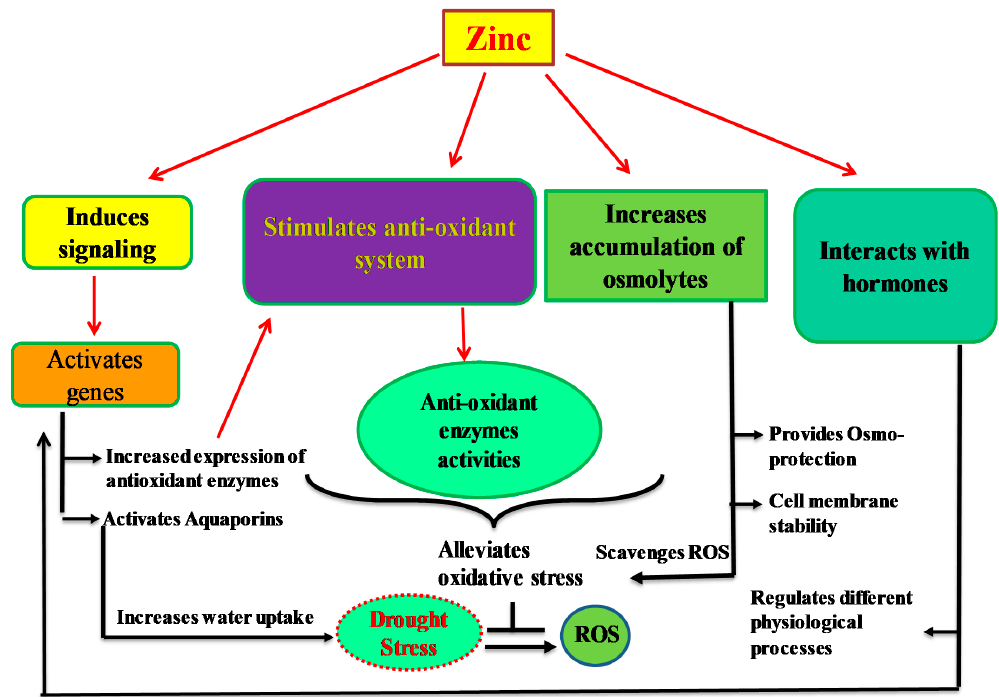
Figure 1. Mechanisms of drought tolerance induce by Zn. Zinc application improves the antioxidant activities, increases osmolyte accumulation, hormonal cross talk and cell signaling, which in turn improve membrane stability, physiological processes including water uptake and ROS scavenging.